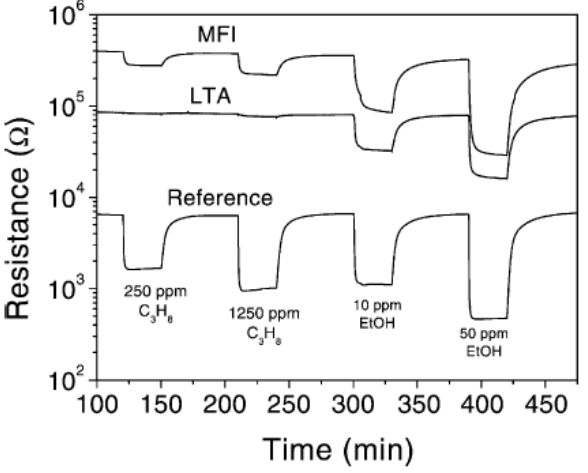
Figure 4. Comparison of response between Pd-SnO A and uncoated for propane and ethanol, showing selectivity to ethanol with zeolite A layer, 350 °C with 50% relative humidity (adapted from Reference